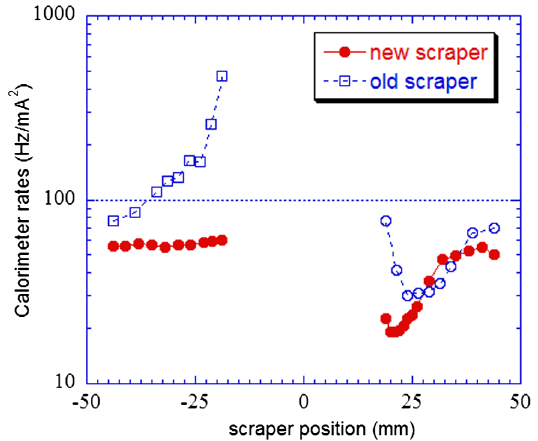
FIG. 7. Scan of the normalized background rate versus the position of the inner scraper edge. The scraper openings are measured from the central beam axis.